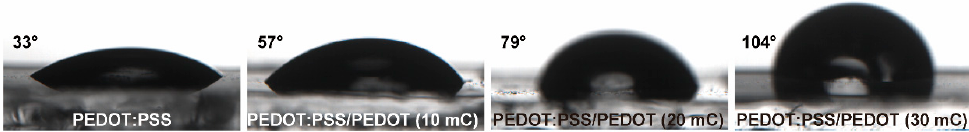
Figure 4. Images of water contact angle test of composite films (PEDOT:PSS, PEDOT:PSS/PEDOT under different electrosynthetic charge amounts).